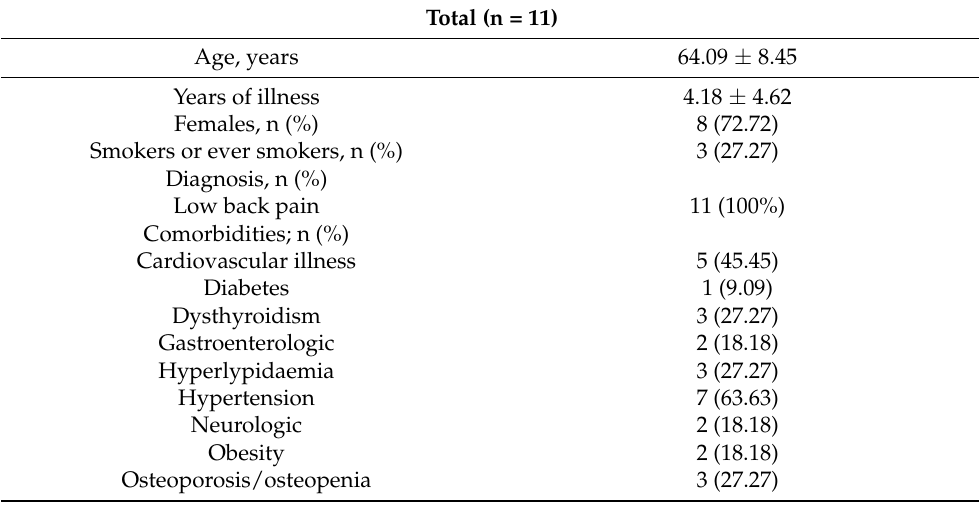
Table 3. Characteristics of the study population enrolled for topical treatment of ketoprofen.